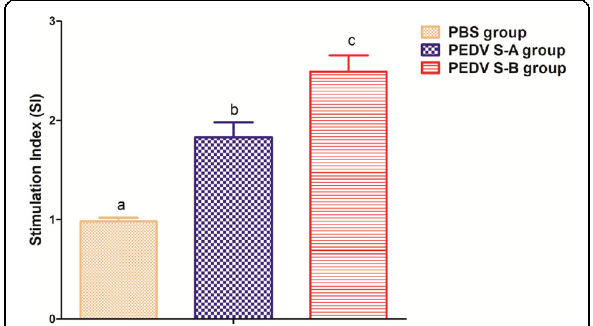
Fig. 4 Lymphocyte proliferation responses measured by MTS assay in mice. Data were represented as the mean ± SEM. Different letters ( a , b ) indicate a statistically significant difference between different experimental groups ( P < 0.05). PEDV, porcine epidemic